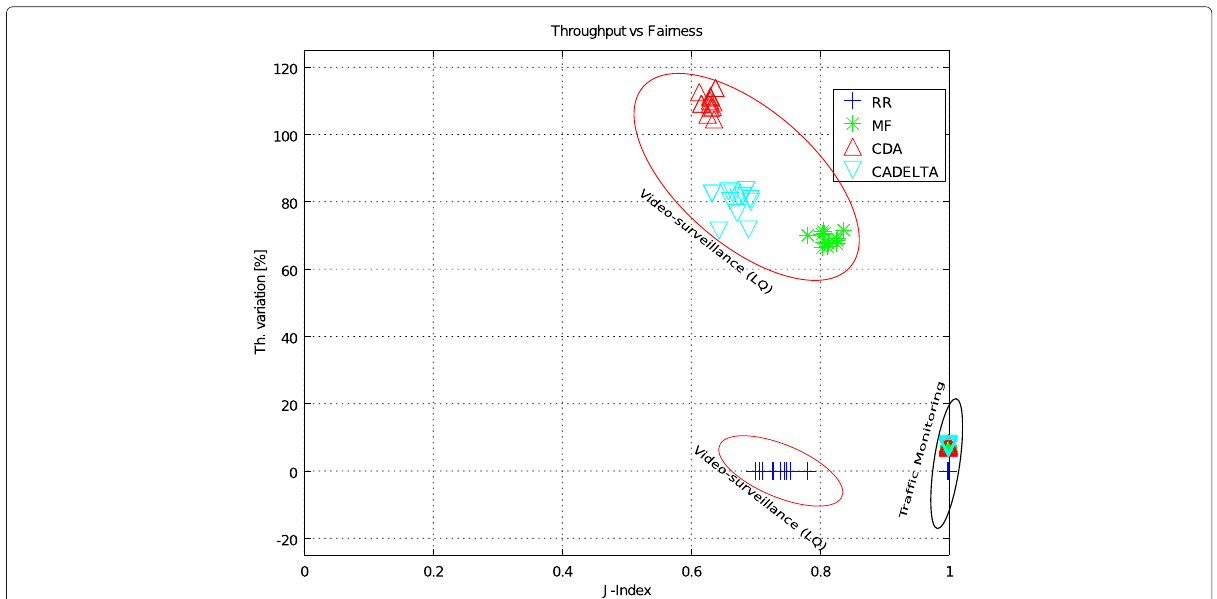
Fig. 6 Throughput vs fairness—video surveillance (LQ), traffic